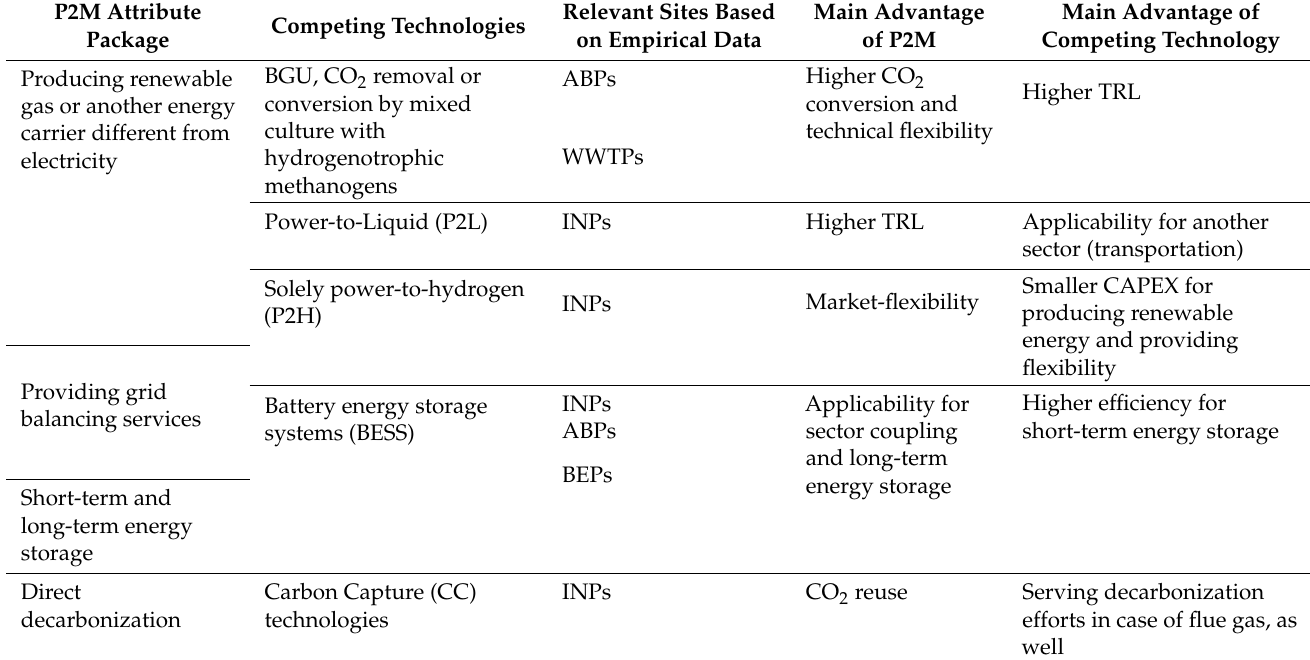
Table 3. P2M attribute package and alternative technologies based on the evaluation of potential adopters iterated with previous